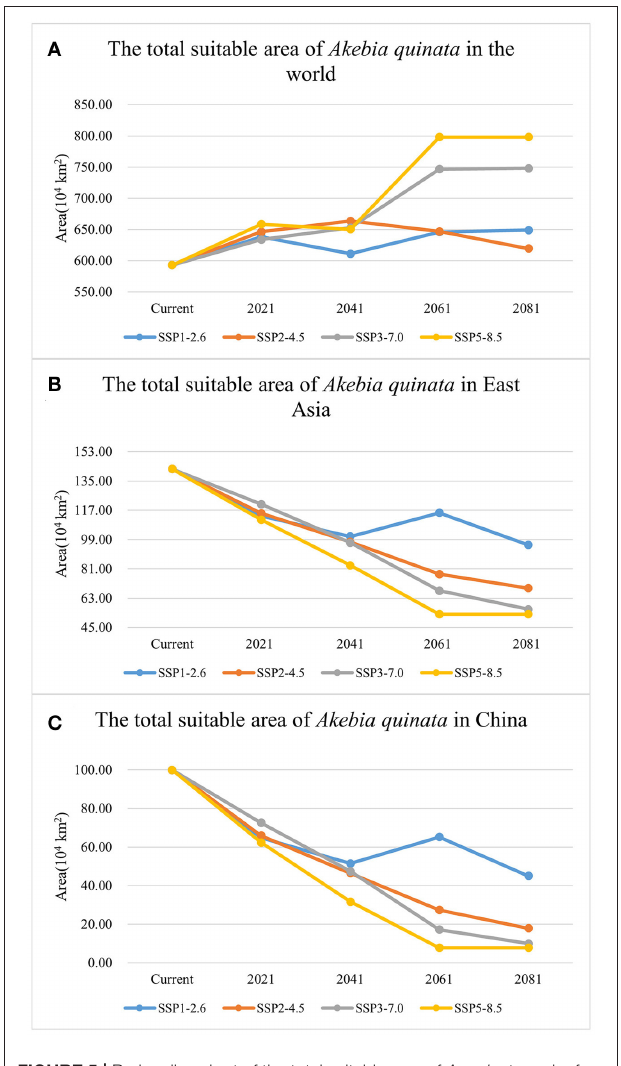
FIGURE 5 | Broken line chart of the total suitable area of A. quinata under four greenhouse climate scenarios. (A) The total suitable area of A. quinata in the world. (B) The total suitable area of A. quinata in East Asia. (C) The total suitable area of A. quinata in